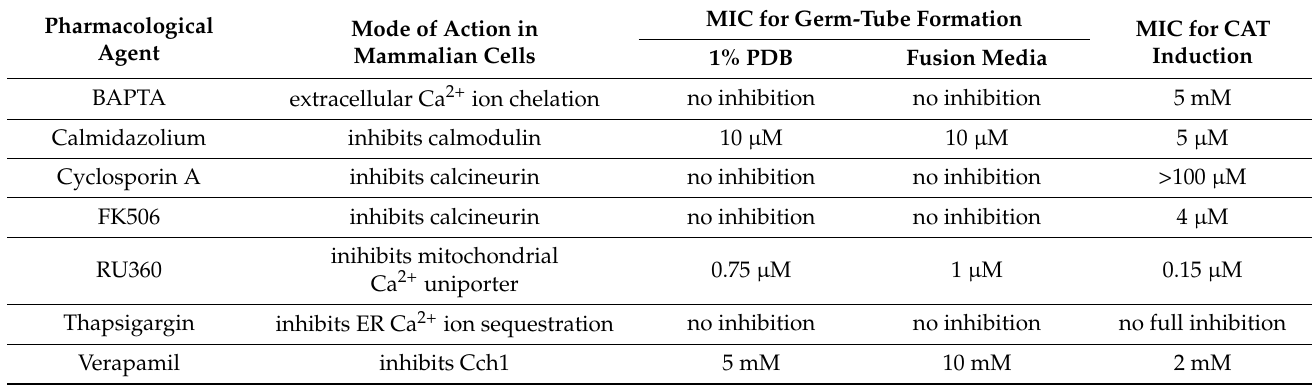
Table 2. Pharmacological inhibition of germ-tube formation and CAT fusion. This table summarizes the effect of each pharmacological agent on germ-tube formation and CAT induction in F. oxysporum . The MIC values are derived from the corresponding graphs shown in Figure